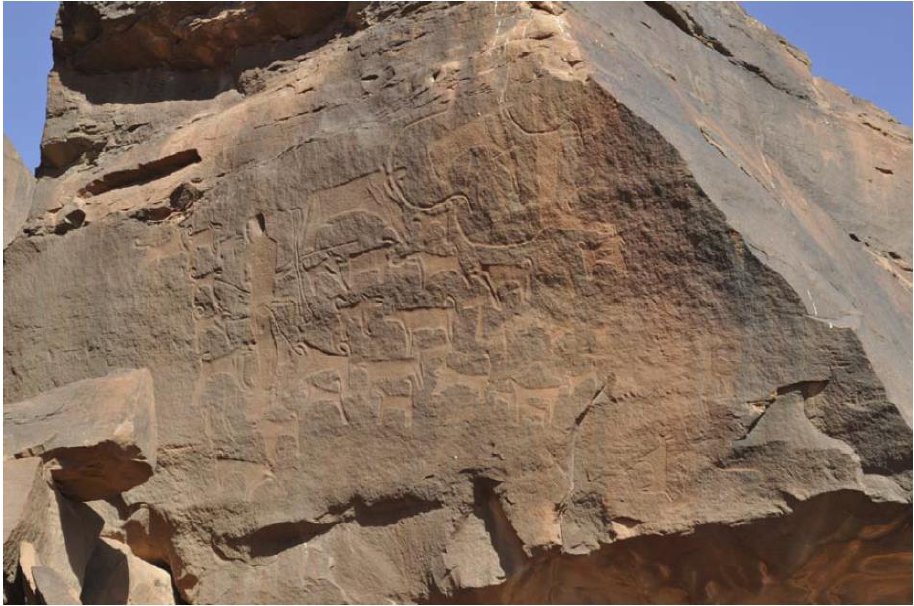
Figure 5. A large composition of human and animal figures at Shuwaymis, northern